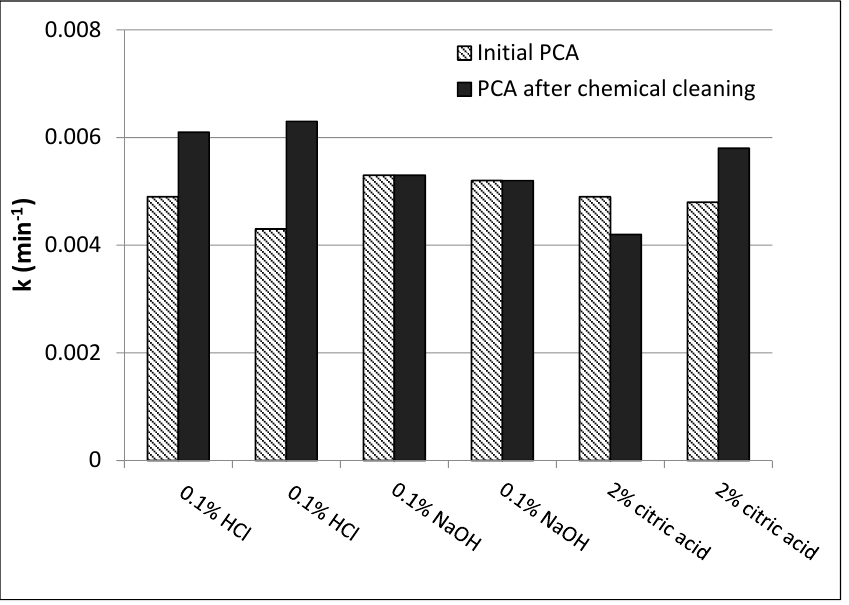
Figure 5. Initial reaction rate constant versus rate constant after 2 h immersion in: 0.1% HCl, 0.1% NaOH or 2% citric acid.